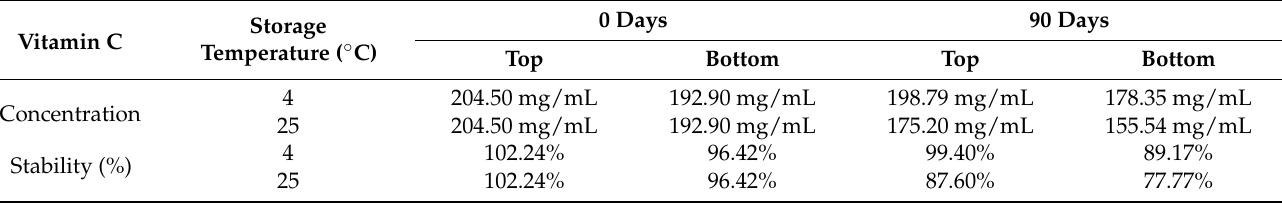
Table 4. Stability of lipid-based vitamin C upon storage at 4 ◦ C and 25 ◦